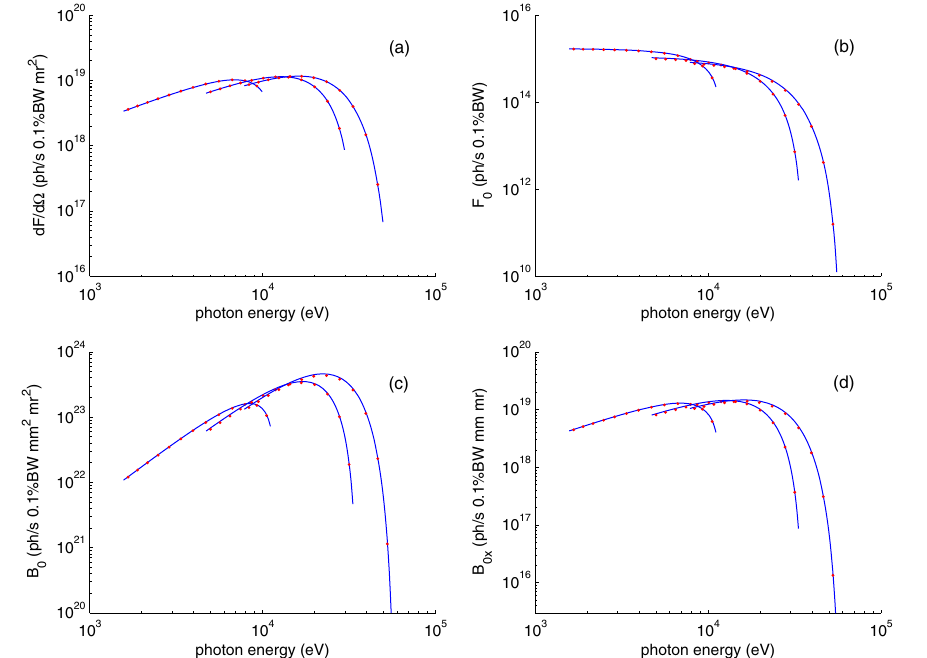
FIG. 10. Comparison of calculated (dots) vs theoretical values (solid curves) for undulator radiation: (a) angular flux density, (b) central cone flux, (c) on-axis 4D brightness, (d) on-axis 2D brightness. The first three odd harmonics are shown. The undulator is ¼ 250 . Refer to the text for other parameters. planar with N u